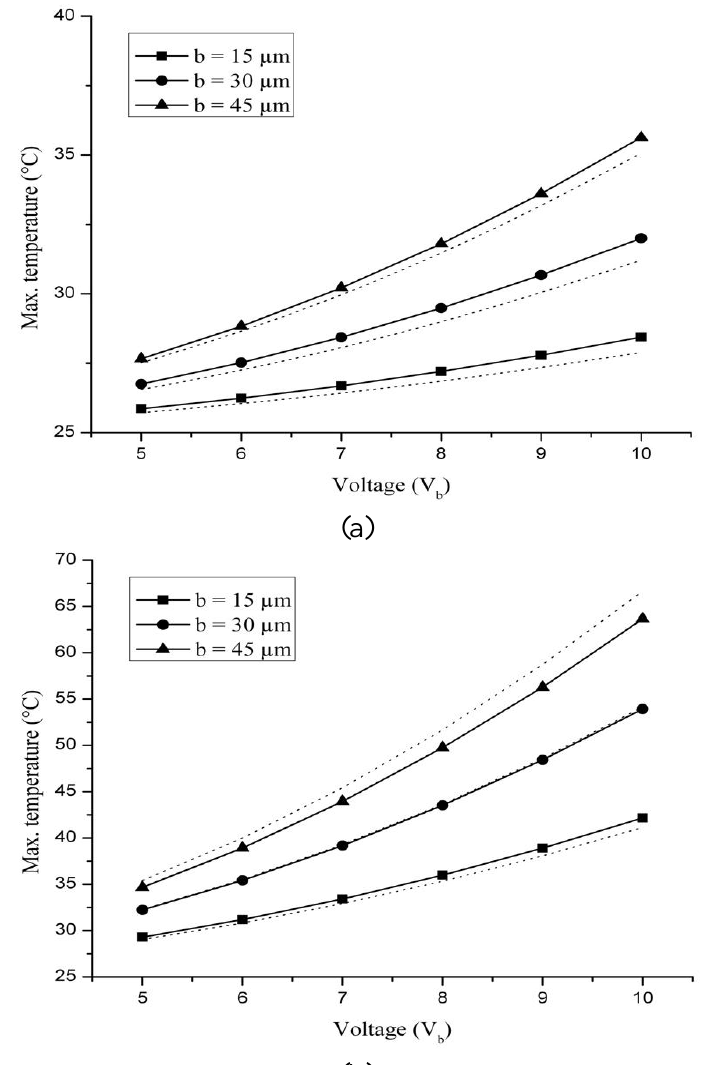
Figure 4. Effect of bias voltage on maximum temperatures generated in silicon (a) and silicon dioxide (b) microcantilever for different piezoresistor width. Dotted lines show analytical